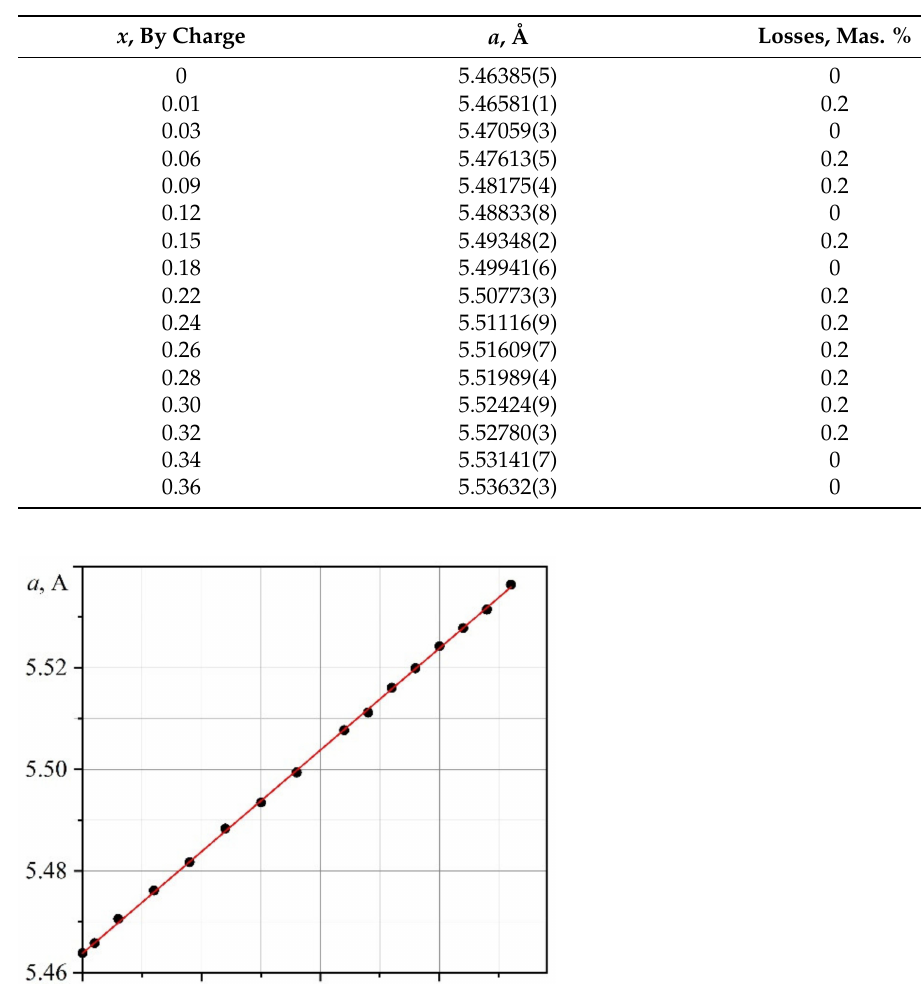
Table 1. Concentration dependence of the lattice parameter of Ca 1– x Y x F 2+ x .